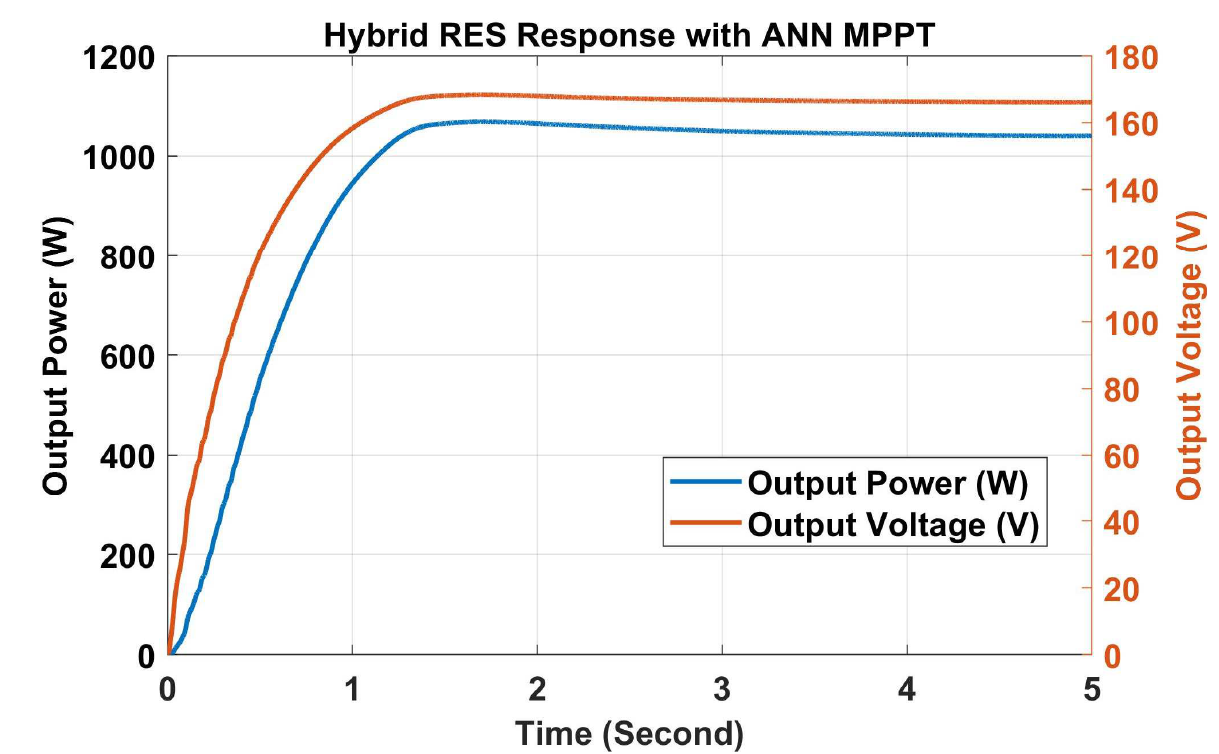
Figure 27. Output Power and Voltage of Hybrid RES with AN-N MPPT.